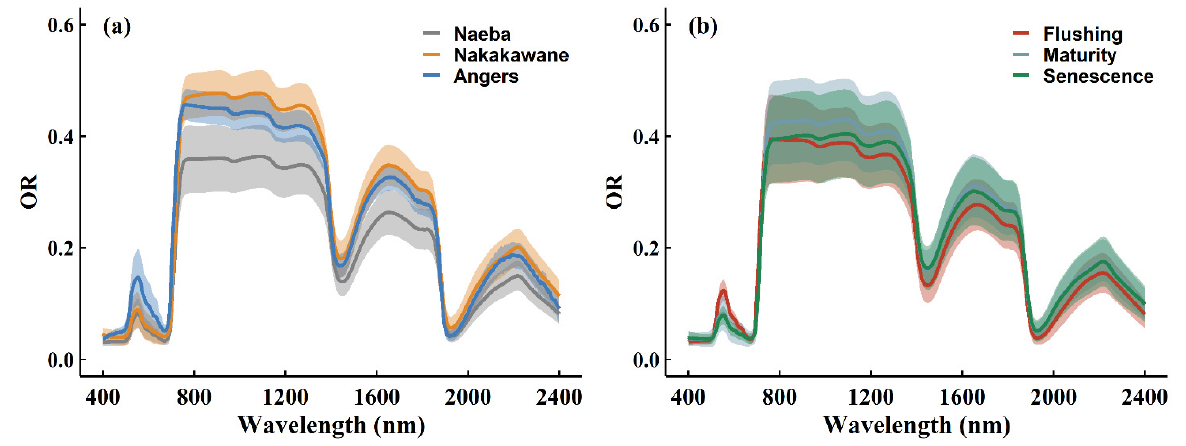
Figure 2. The corresponding original reflectance (OR) data in the Naeba, Nakakawane, and Angers datasets ( a ), and during the flushing, maturity, and senescence stages ( b ). Solid lines and shading zones represent the averages of the original reflectance values and the corresponding standard deviations, respectively.